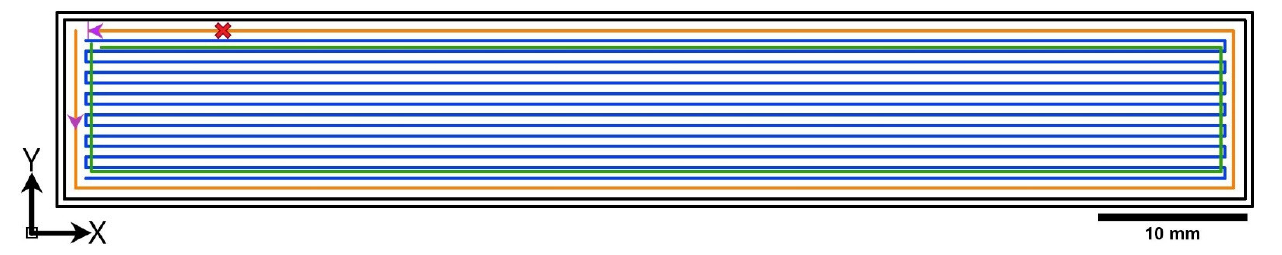
Figure 2. Graphical representation of part configuration generated via slicing software. Black coloured lines are outer thermoplastic perimeters, green coloured line represents micro infill thermoplastic filling by MEX print head, and orange and blue series lines are CCF reinforced perimeter and infill by CFC print head. The purple pointed arrow shows the direction of CCF printing and the pattern “x” marks the symbolic fibre cut operation.